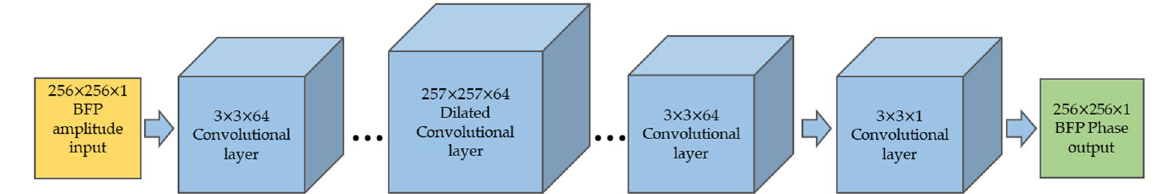
Figure 3. Shows the CAN network with a single BFP image input (256 pixels × 256 pixels), one BFP phase output (256 pixels × 256 pixels), and hidden